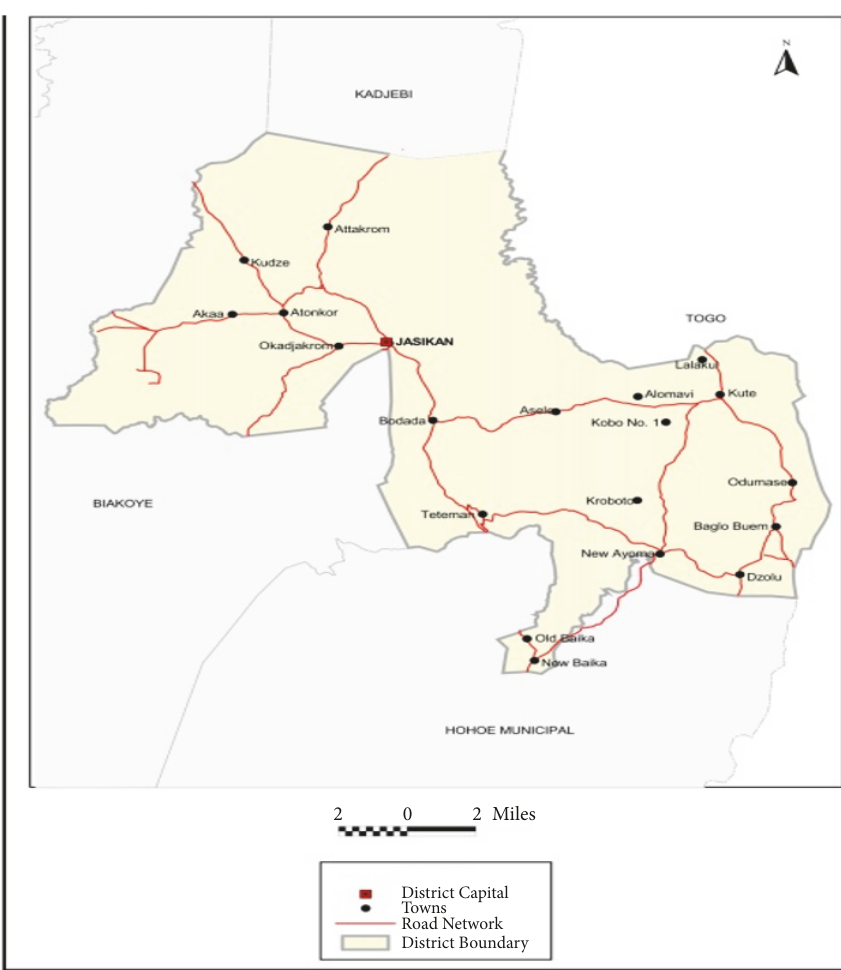
Figure 8: Map of Jasikan District. Source: GSS